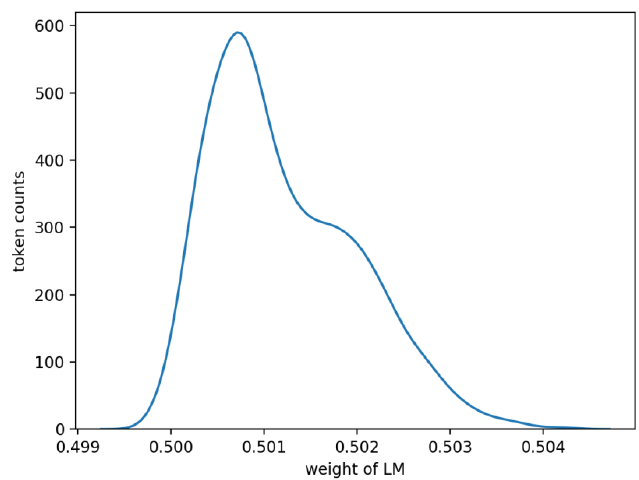
Figure 3. Dynamic weight distribution on dev